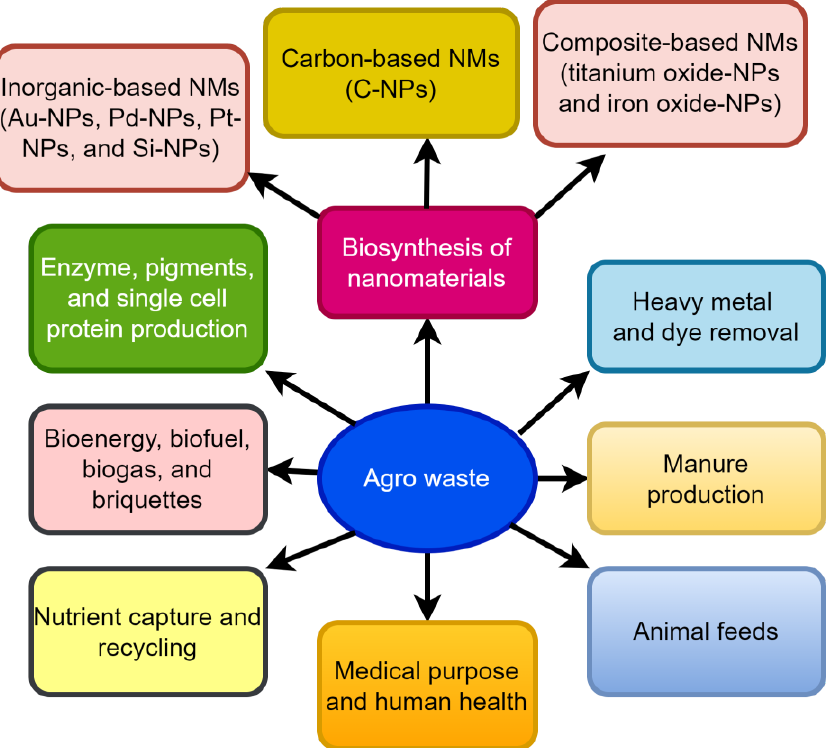
Figure 1. Management of